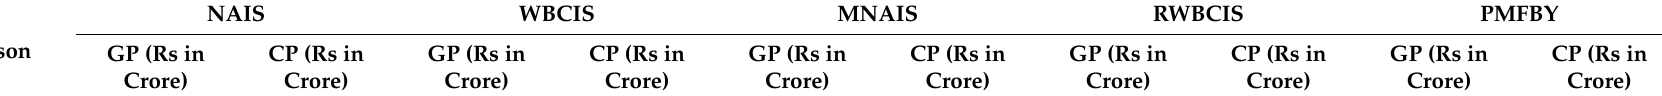
Table 5. Season-wise comparison of gross premium collection amounts and claims paid under crop insurance schemes during 2000–2001 to